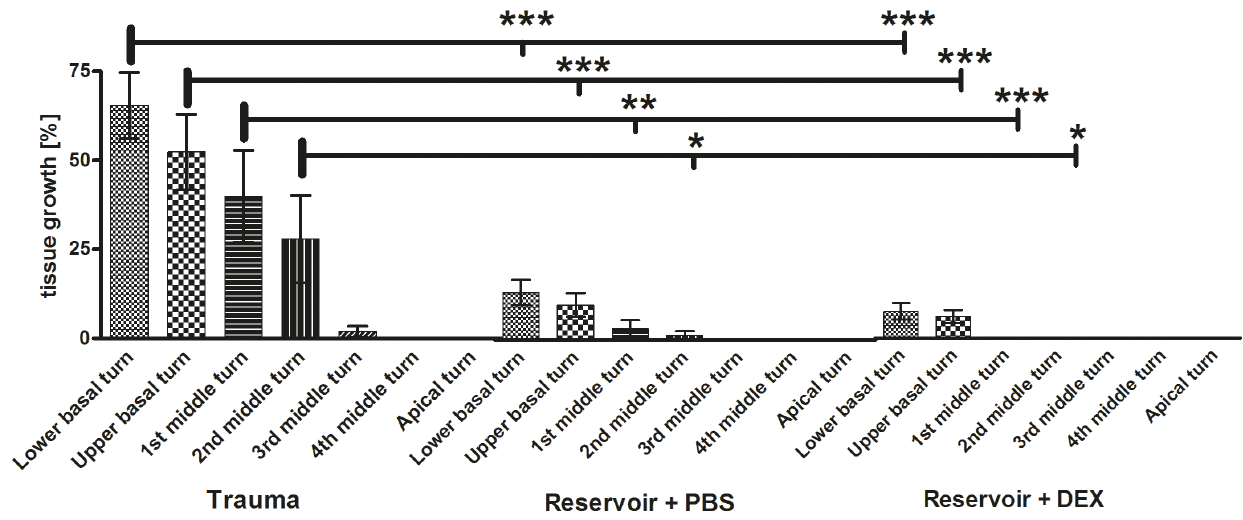
Figure 6. In this graph the mean and SEM percentage of measurement of connective tissue growth in the scala tympani of all experimental groups for each cochlear turn from basal to apical are plotted. The comparison of tissue growth between the groups is illustrated by horizontal lines. Reference of the significance is marked by the thick bar. Highly significant differences were observed between tissue growth in the trauma group and groups receiving PBS or DEX by reservoir. No differences were measured between PBS or DEX treated groups even though a slightly increased connective tissue growth seems to be apparent in the PBS group compared to DEX treated animals. In cochleae implanted with a PBS releasing reservoir tissue growth could be measured from basal up to the 2 nd middle turn whereas in the reservoir and DEX treated cochleae connective tissue formation was only visible in the lower and upper basal region. One-way ANOVA in combination with the Tukey post-test was used to compare means between groups: *=p , 0.05; **=p , 0.01; ***=p ,